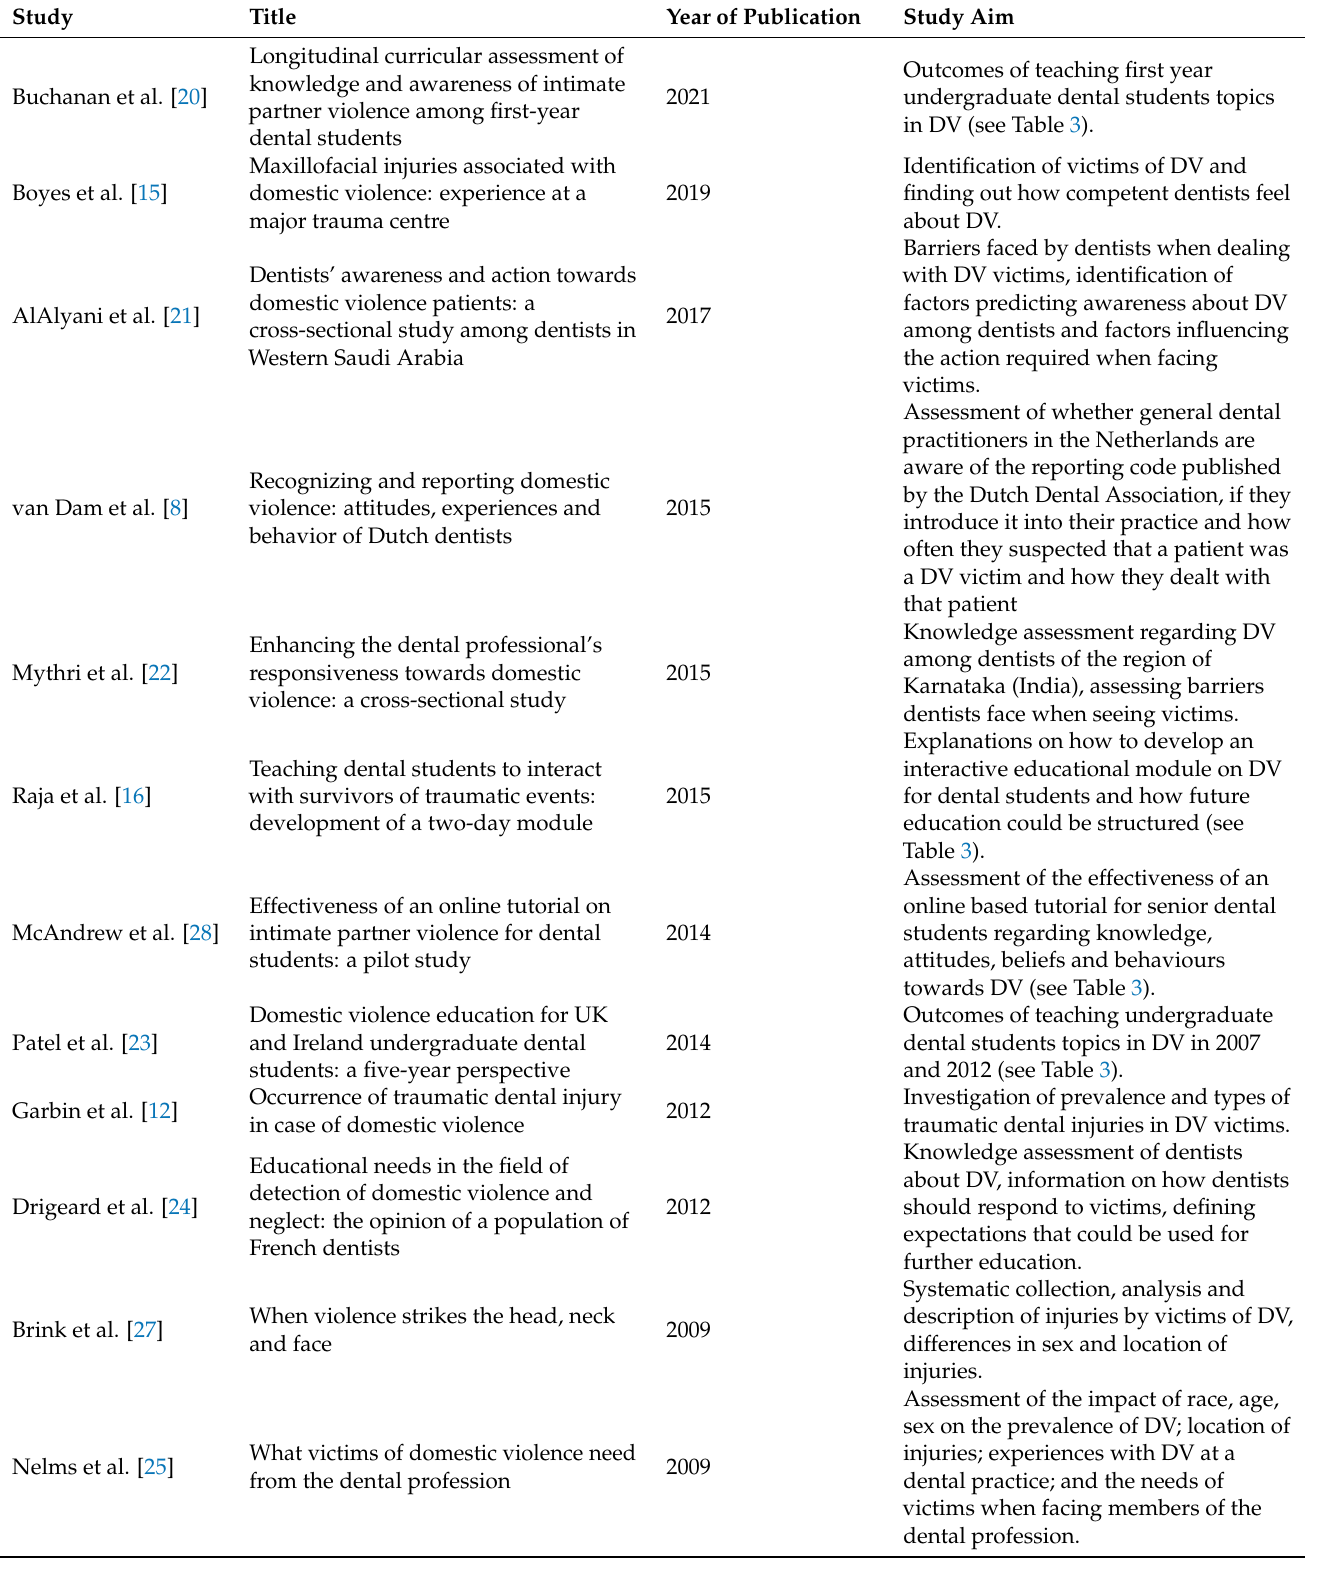
Table 2. Overview of all studies (n = 17) included in this review according to our eligibility criteria (see Figure